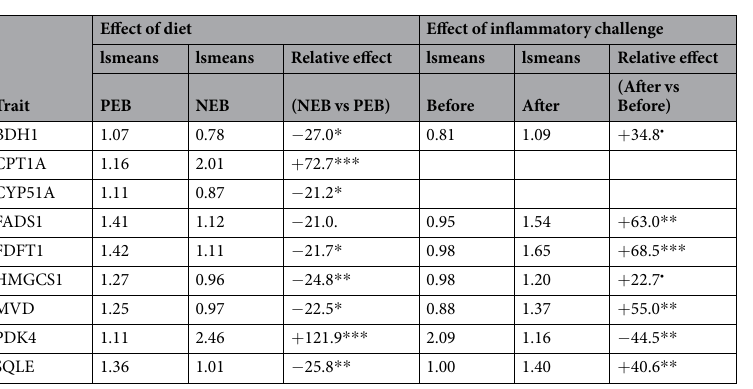
Table 3. Analysis of variance (linear mixed model) of the effect of diet (Positive Energy Balance: PEB vs Negative Energy Balance: NEB) and of the inflammatory challenge (after vs before) on RT-qPCR data measured in a different set of samples. Variation between two conditions (B compared to A) was calculated as a relative difference in lsmeans: (lsmeansB-lsmeansA)/lsmeansA. NEB ewes (n = 12) were compared to PEB ewes (n = 12). Gene expression after the inflammatory challenge (n = 24) was compared to gene expression before the inflammatory challenge (n = 24). Significant effects were highlighted by stars: ∙ P < 0.1, * P < 0.05, ** P < 0.01 and *** P <